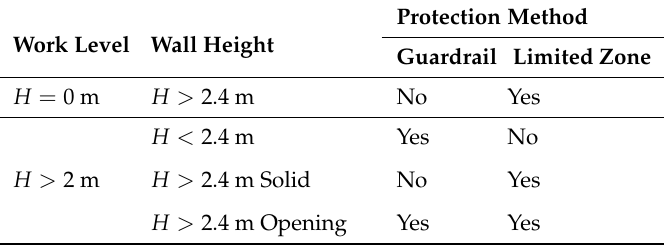
Table 4. OSHA safety regulation for masonry works in the unprotected side.